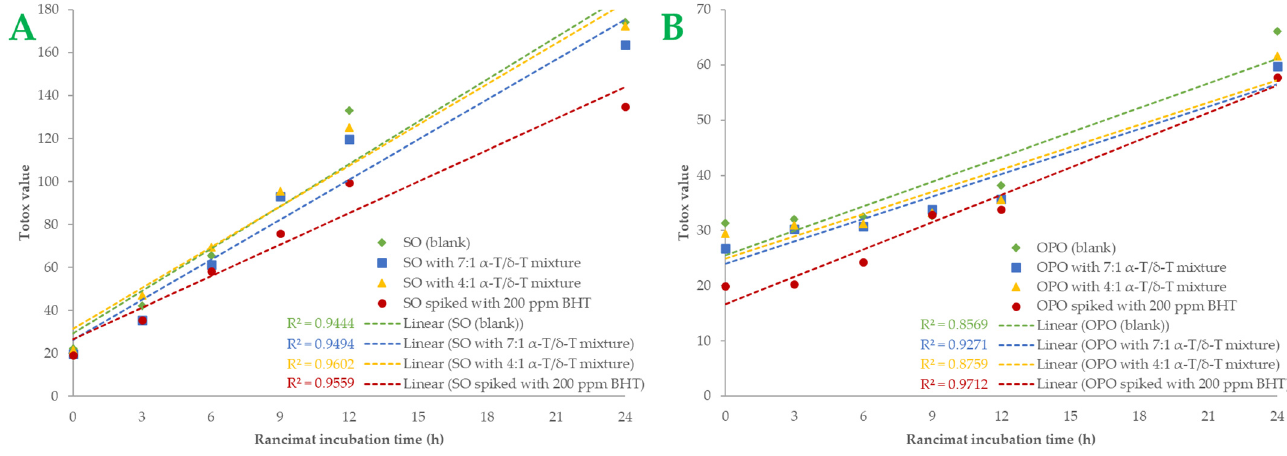
Figure 4. Totox values of the samples of sunflower oil (plot A ) and olive pomace oil (plot B ) are shown as linear curves over the Rancimat incubation time (h). Each sample’s R-squared (R 2 ) is shown.